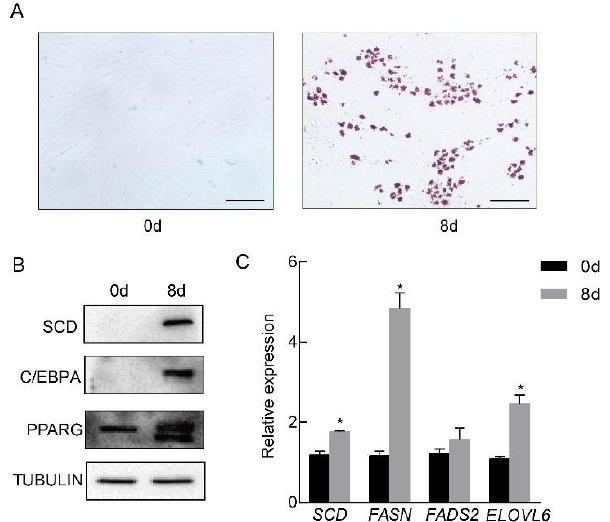
Figure 2. SCD was significantly up-regulated in differentiated porcine adipocytes. Porcine preadipocytes were primarily cultured and differentiated into mature adipocytes in vitro. ( A ) Left: nondifferentiated preadipocytes; right: oil red O staining of the differentiated cells. Positive staining indicated lipid droplet formation. Scale bar, 100 μm. ( B ) The expression levels of SCD and the adipocyte differentiation marker genes PPARG and C/EBPA in preadipocytes and differentiated adipocytes. TUBULIN was used as a loading control. ( C ) The expression levels of genes related to lipid synthesis were measured in preadipocytes and differentiated adipocytes ( n = 3 / group), * p <